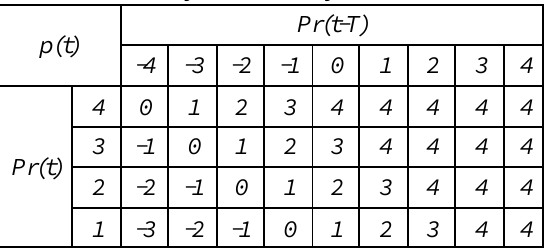
Table 4. Index systems of fuzzy rules for